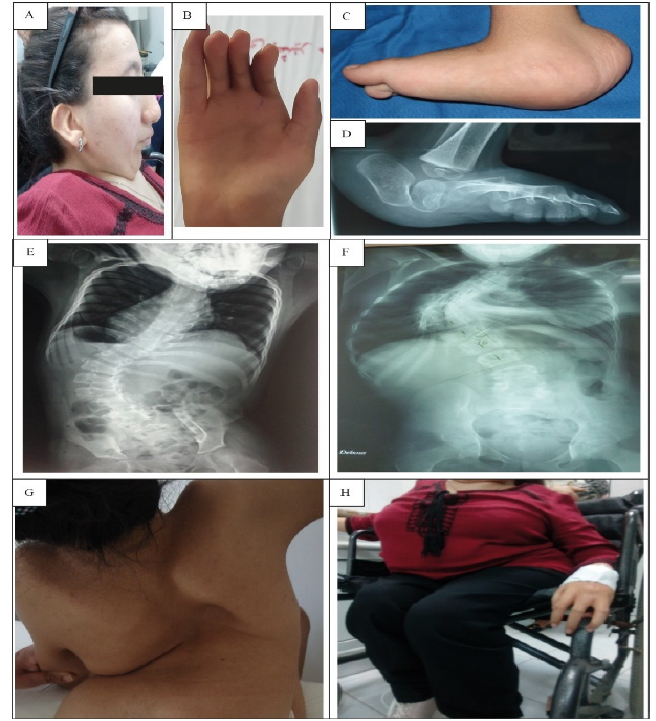
Figure 1. Radiological imaging and photos of patients with Escobar syndrome: ( A ) facial dysmorphism in Escobar patients; ( B ) camptodactyly; ( C , D ) foot deformities of Patient 1; ( E – G ) scoliosis of Patients 1–3, respectively; ( H ) paraplegia of Patient 3.